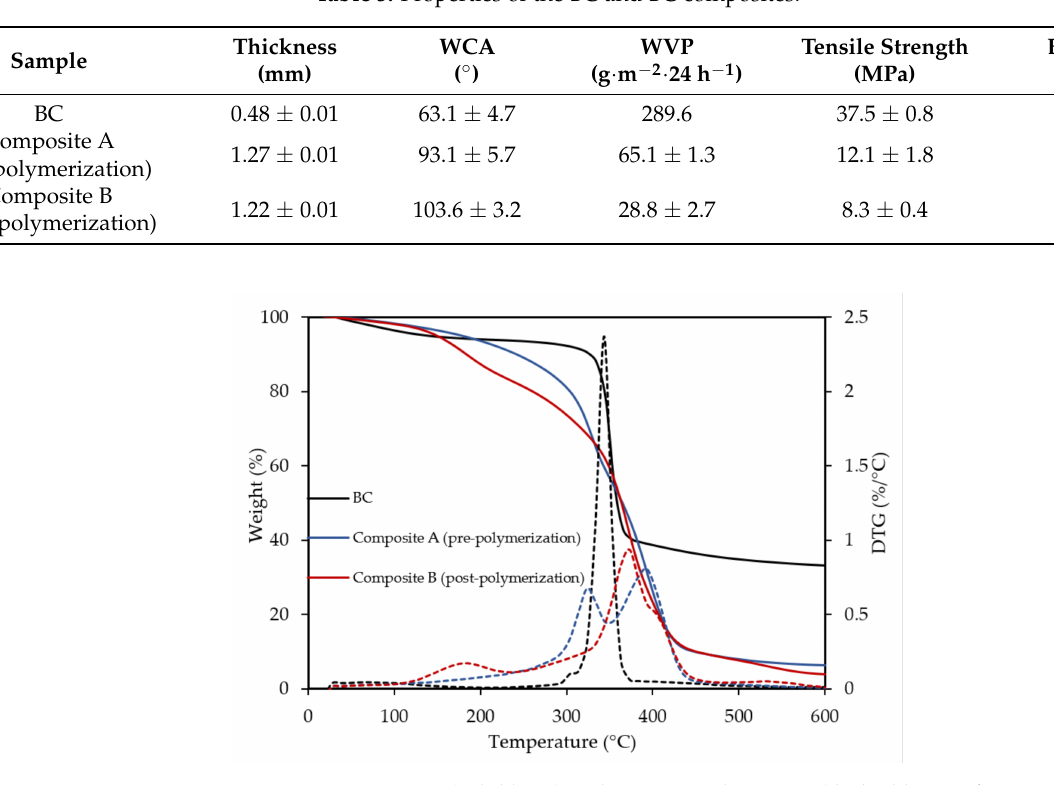
Figure 1. TGA curves (solid lines) and respective derivative (dashed lines) of BC and BC composites.